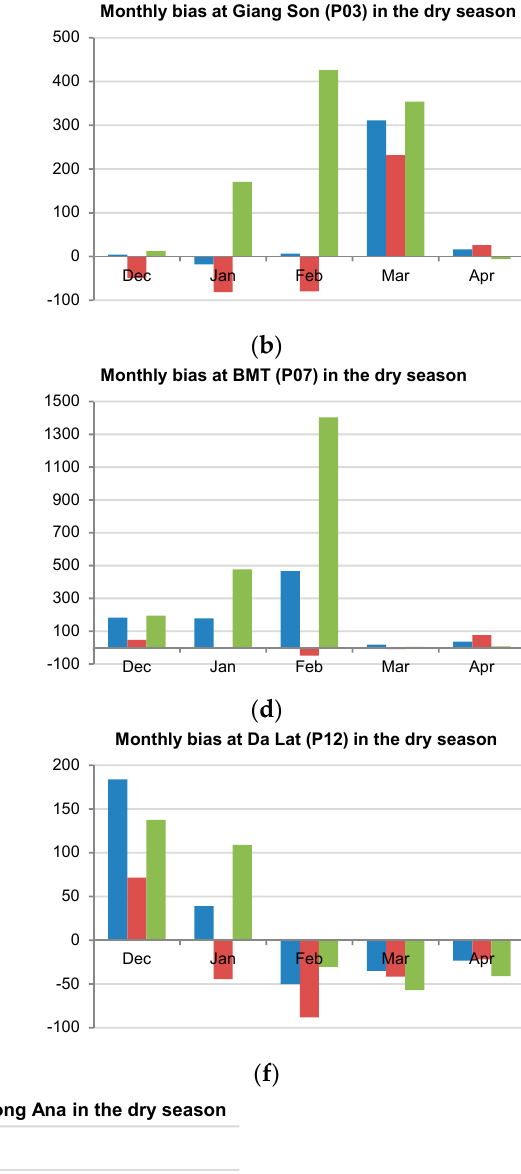
Figure 4. Comparison of average monthly rainfall patterns (2003–2010) from different data sources at different stations and Krong Ana Sub-catchment: ( a ) at Krong Buk station (P01), ( b ) at Giang Son station (P03), ( c ) at Buon Ho station (P06), ( d ) at BMT station (P07), ( e ) at M'Drak station (P09), ( f ) at Dat Lat station (P12), and ( g ) at Krong Ana Sub-catchment.